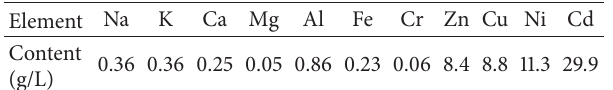
Table 1: Main element content of electroplating